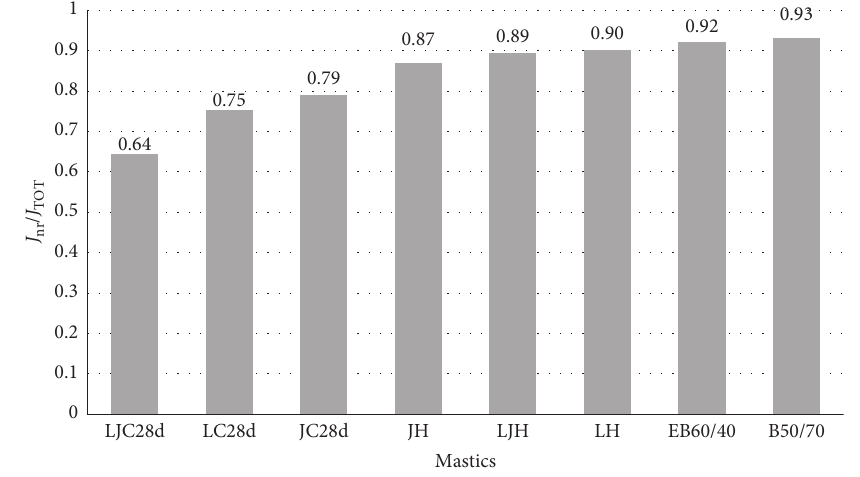
Figure 13: J / J results under 3.2kPa and 60 ° C. nr TOT Table 7: J results: (a) LJH/LH and (b) LJC28d/LJ28d. nr ratio